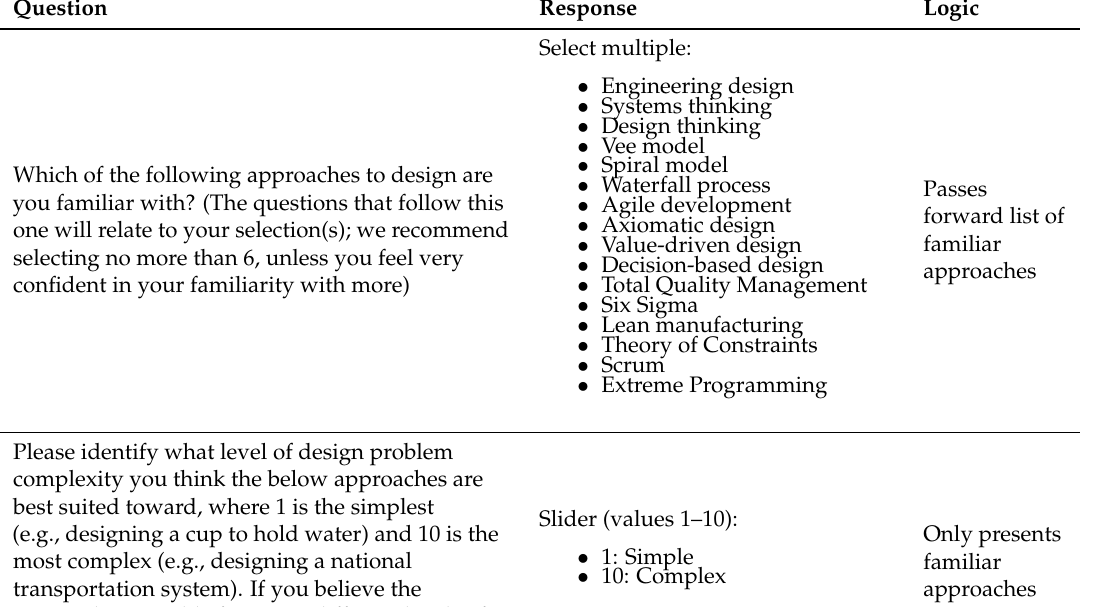
Table A3. Questions about design